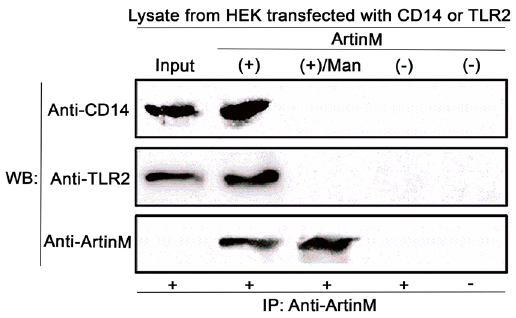
Figure 7. ArtinM binding with CD14 by carbohydrate recognition. Protein lysate (100 µ g) from HEK cells transfected with CD14 or TLR2 was assayed. The protein lysate was incubated [ + ] or not [ − ] with ArtinM (10 µ g) for 16 h at 4 °C. The protein lysate samples had been preincubated or not with Man α 1-3(Man α 1-6)Man [Man]. Then, 10 µ g purified anti-ArtinM immunoglobulin [IP: anti-ArtinM] was added [ + ] or not [ − ] and the mixture was centrifuged and washed with ice-cold acetone. Precipitated material was analyzed with WB by anti-CD14, anti-TLR2, or anti-ArtinM